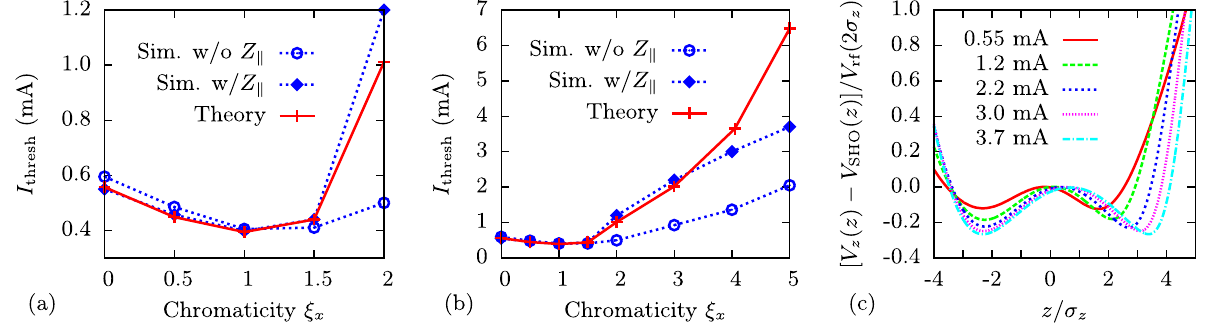
FIG. 7. Effect of adding a longitudinal impedance Z ∥ . Panel (a) shows that both theory and simulation predict a reduction in I low ξ , which can be attributed to the decrease in the effective synchrotron frequency. At higher ξ x lengthening due to Z ∥ increases the maximum stable current, and the theory agrees well with the simulation for ξ larger currents the theory overestimates I simple harmonic oscillator at the simulation-predicted I